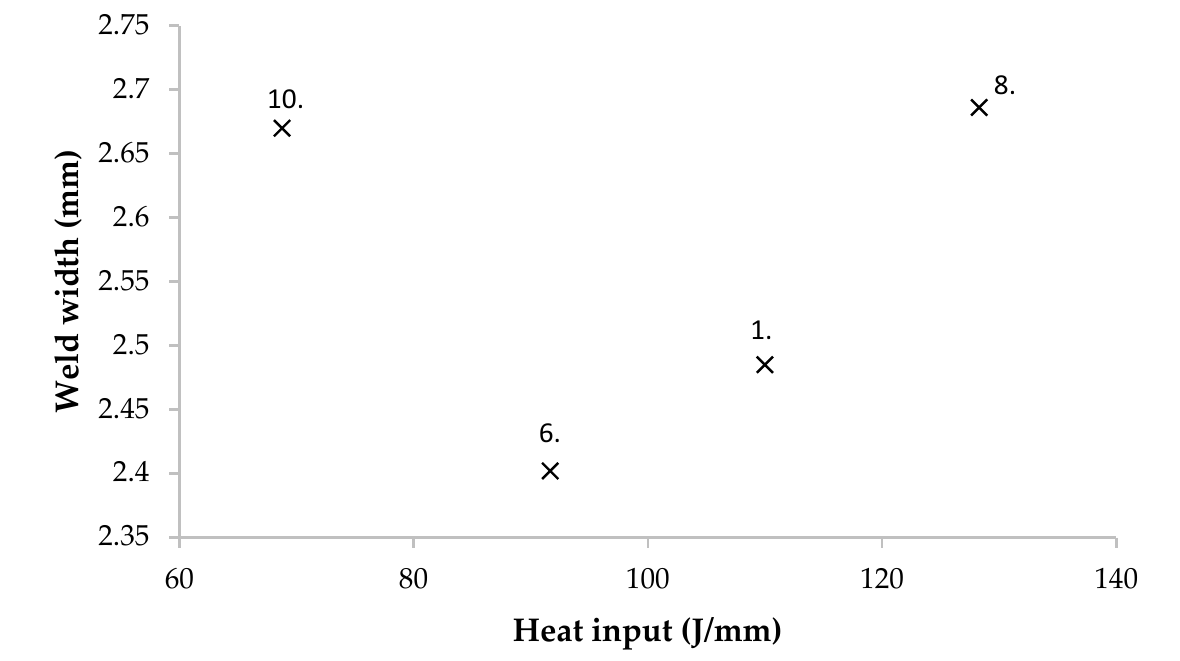
Figure 5. Dependence of heat input (J/mm) on weld width (mm) for samples 1, 6, 8, and 10.